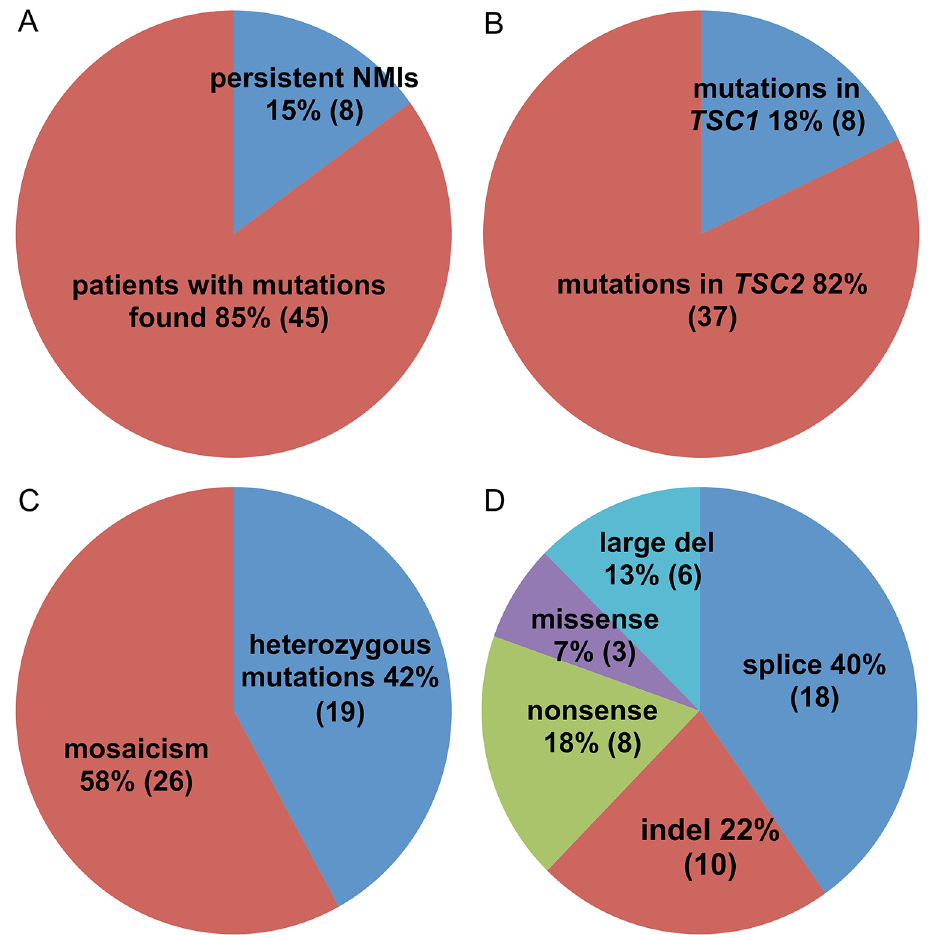
TSC2 . (C) Proportion of heterozygous vs. mosaic mutations. (D) Different types of identified mutations.